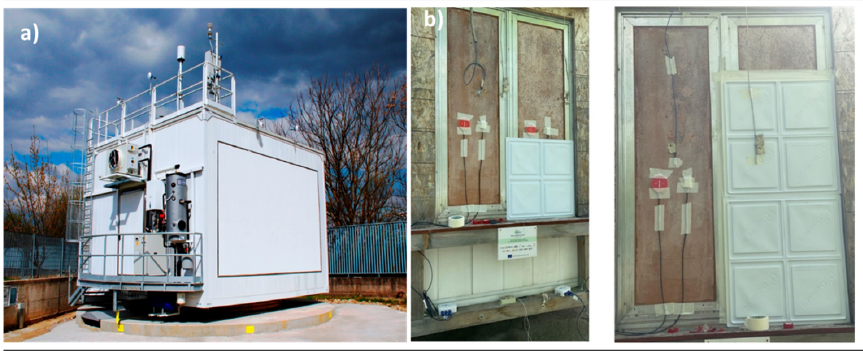
Figure 1. ( a ) MATRIX layout. ( b ) Installation of system under investigation for further studies. For the simulations, the hourly weather file was created with data monitored from April 2014 to December 2021 by means of the climatic station on the roof of the laboratory. According to monitored values, Benevento has a typical Mediterranean climate and it is inside the Csa zone according to Köppen classification